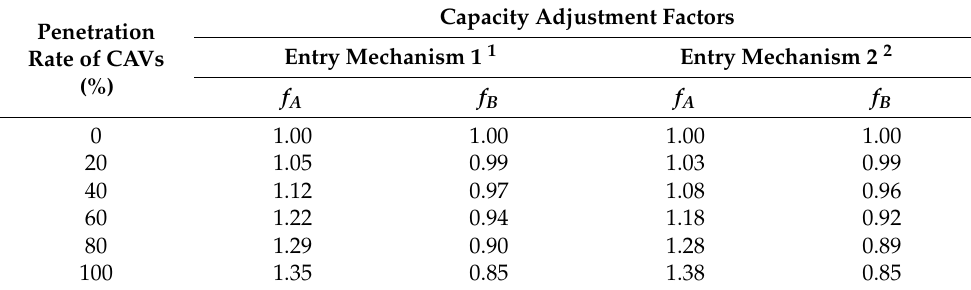
Table 1. Capacity adjustment factors by penetration rate of CAVs for roundabouts. Source: Own research based on data presented in